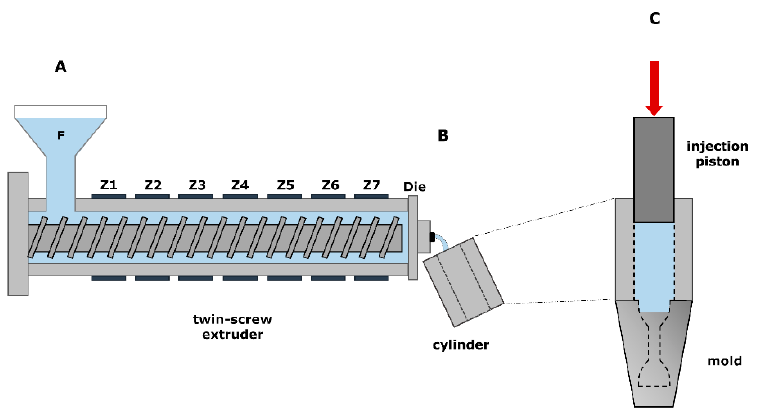
Figure 1. Three-step PHA melt processing with twin-screw extrusion through nine temperature zones ( A ), melt transfer into heated injection cylinder ( B ) and piston melt injection into a heated dumbbell-shaped mold ( C ).